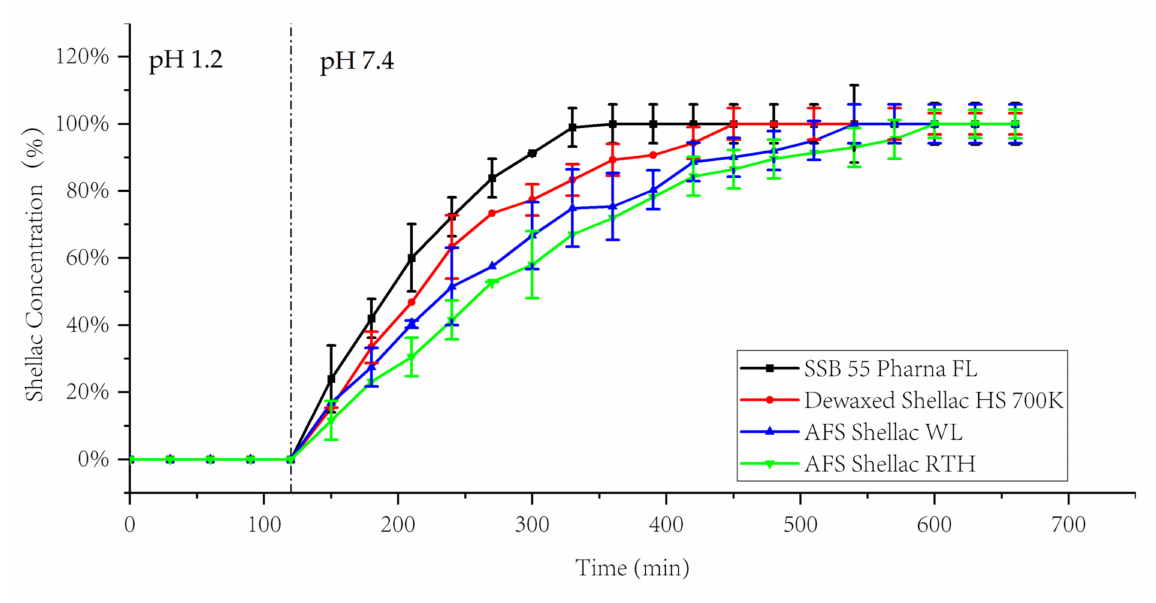
Figure 8. Dissolution profiles of the investigated shellac types at various